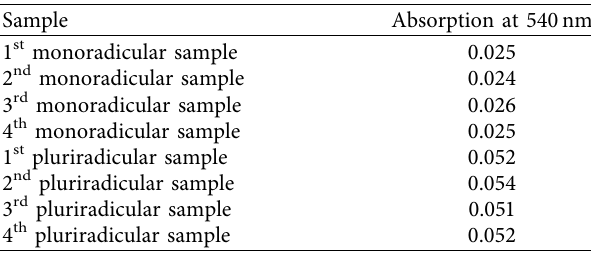
Table 1: Absorbance values obtained for the samples prepared using the Coltosol temporary